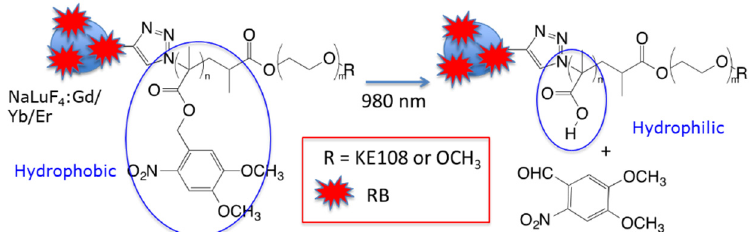
Figure 11. Illustration of NIR-triggered hydrophobic-to-hydrophilic transition leading to the release of hydrophobic drug. Adapted from Chen et al. [28].